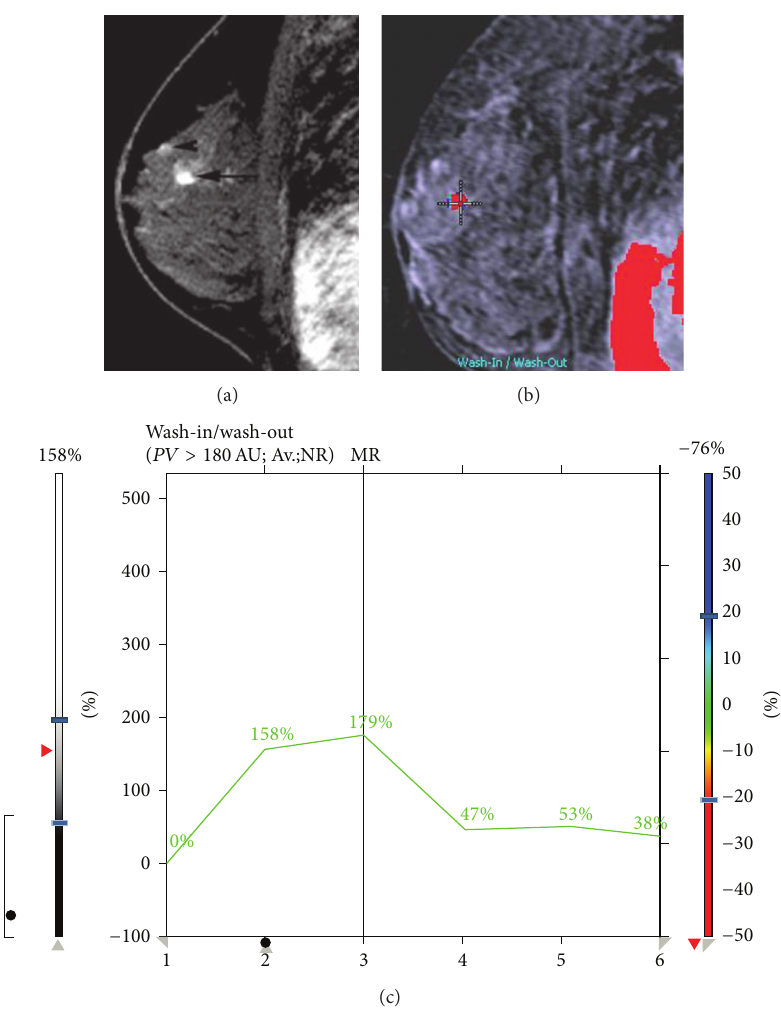
Figure 5: Eighteen months later, in the left breast a new distinct irregular 8mm lesion (black arrow) and a 4 mm focus (arrowhead) were noted. The 8mm irregular mass has wash-out kinetics (b), (c) for which MR-guided biopsy was recommended; the 4mm focus does not meet threshold criteria for enhancement. Pathology of the suspicious lesion based on morphology and kinetics was invasive ductal carcinoma on histology. The anterior focus was involvement by